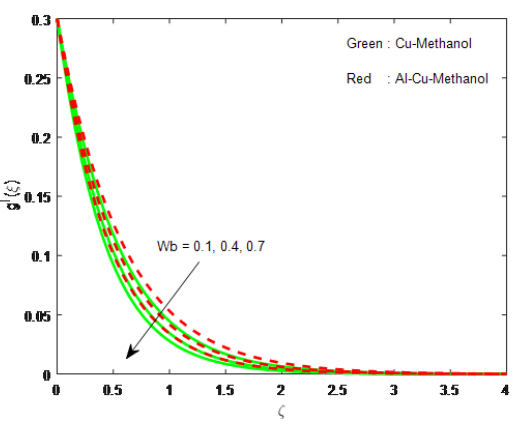
Fig. 10: Impression of wb on θ ( ξ )